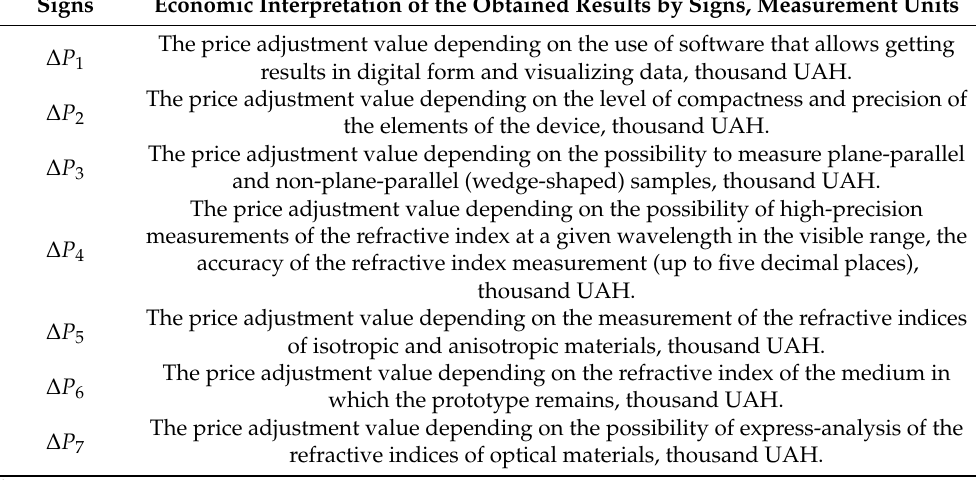
Table 7. Interpretation of the results of the evaluation of the influence of competitive characteristics on the price formation for the device of the interferometric determination of the refractive index of crystalline materials in the optical range 1